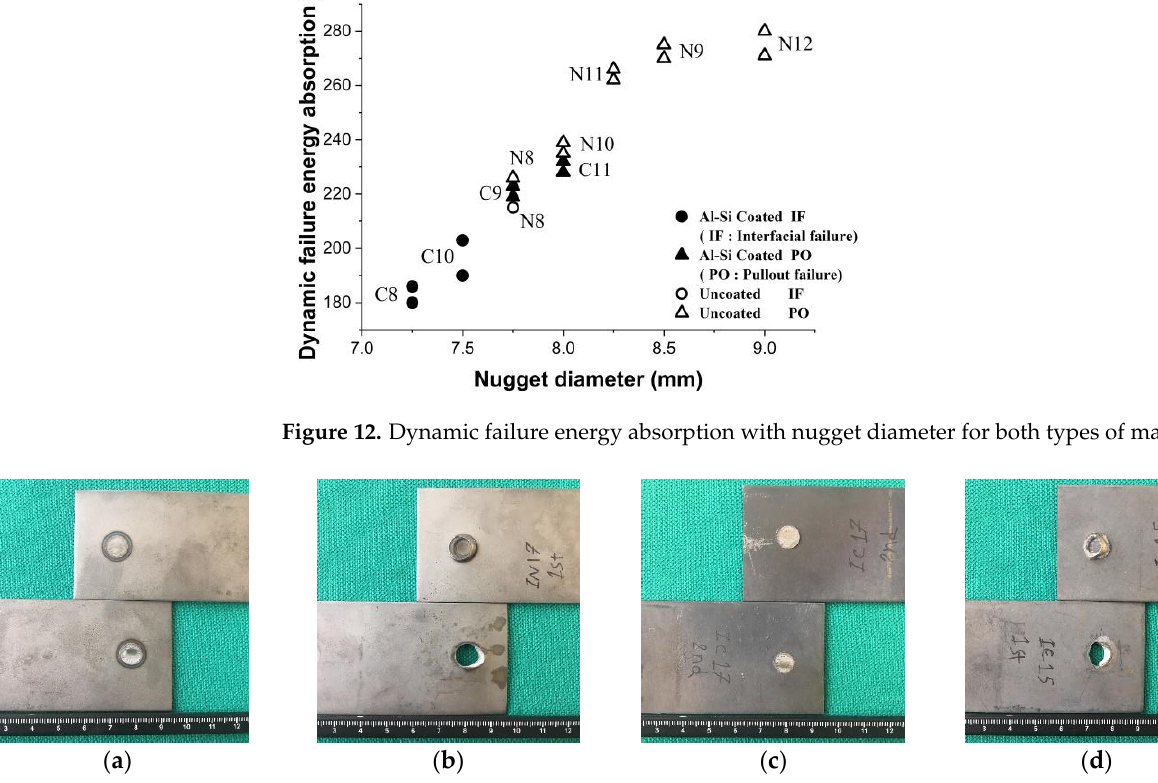
Figure 13. Typical failure modes of the specimens after impact test: ( a ) interfacial failure (IF) in uncoated material (Sample No, N8); ( b ) pullout failure (PO) in uncoated material (Sample No, N11); ( c ) IF failure in Al-Si coated material (Sample No, C10); and ( d ) PO failure in Al-Si coated material (Sample No, C9).